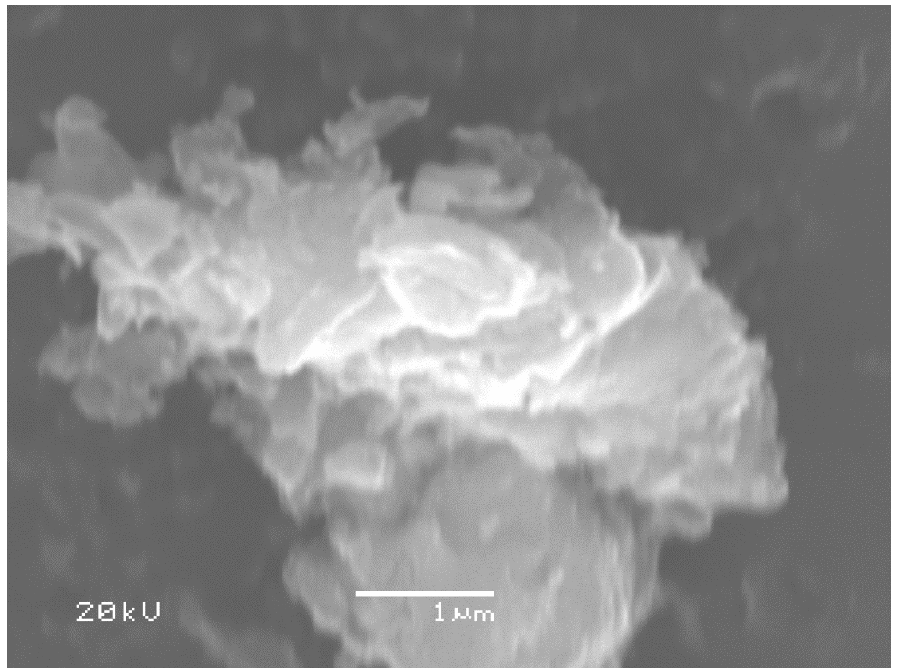
Figure 3. SEM image of activated carbon at a magnification of 20,000×.